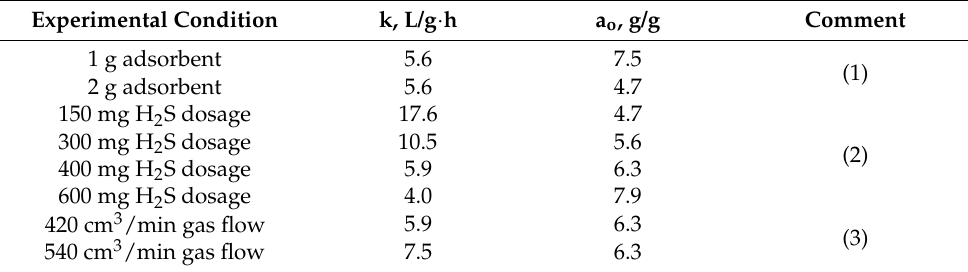
(1) Data corresponding to Figure 6a. (2) Data corresponding to Figure 6b. (3) Data corresponding to Figure 6c.